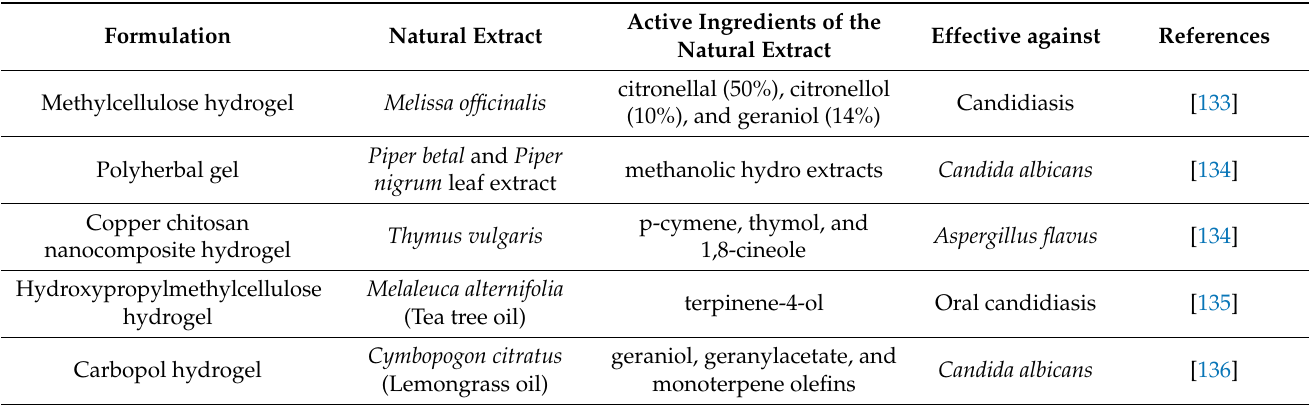
Table 7. Natural extract entrenched antifungal